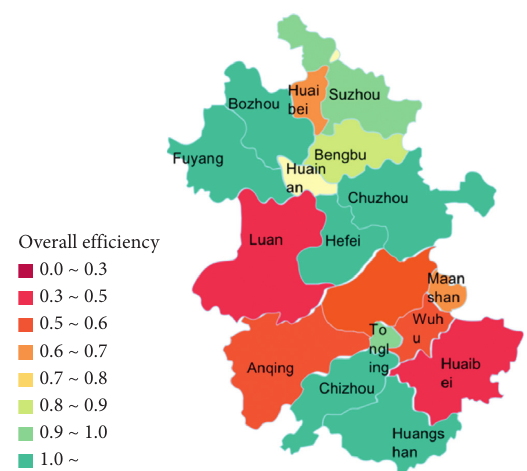
Figure 4: Overall efficiency 2015.